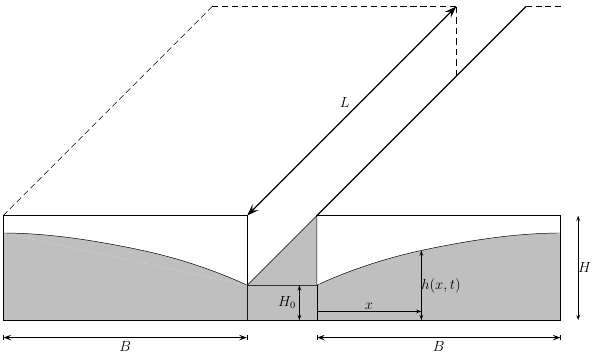
Figure 1. Schematic of a watershed of simple geometry during a hydrologic